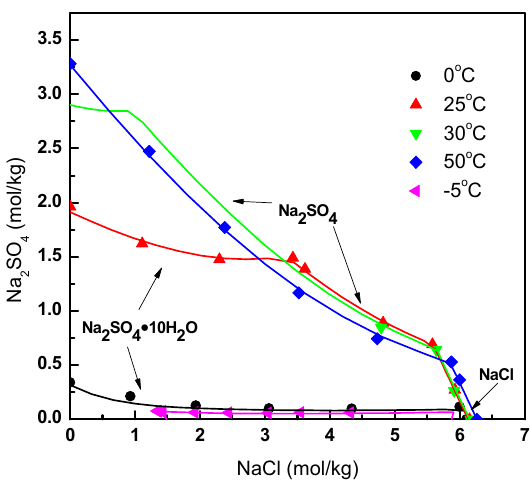
Figure 2. Comparison of experimental (point) and calculated values (line) of NaCl–Na 2 SO 4 solubility.